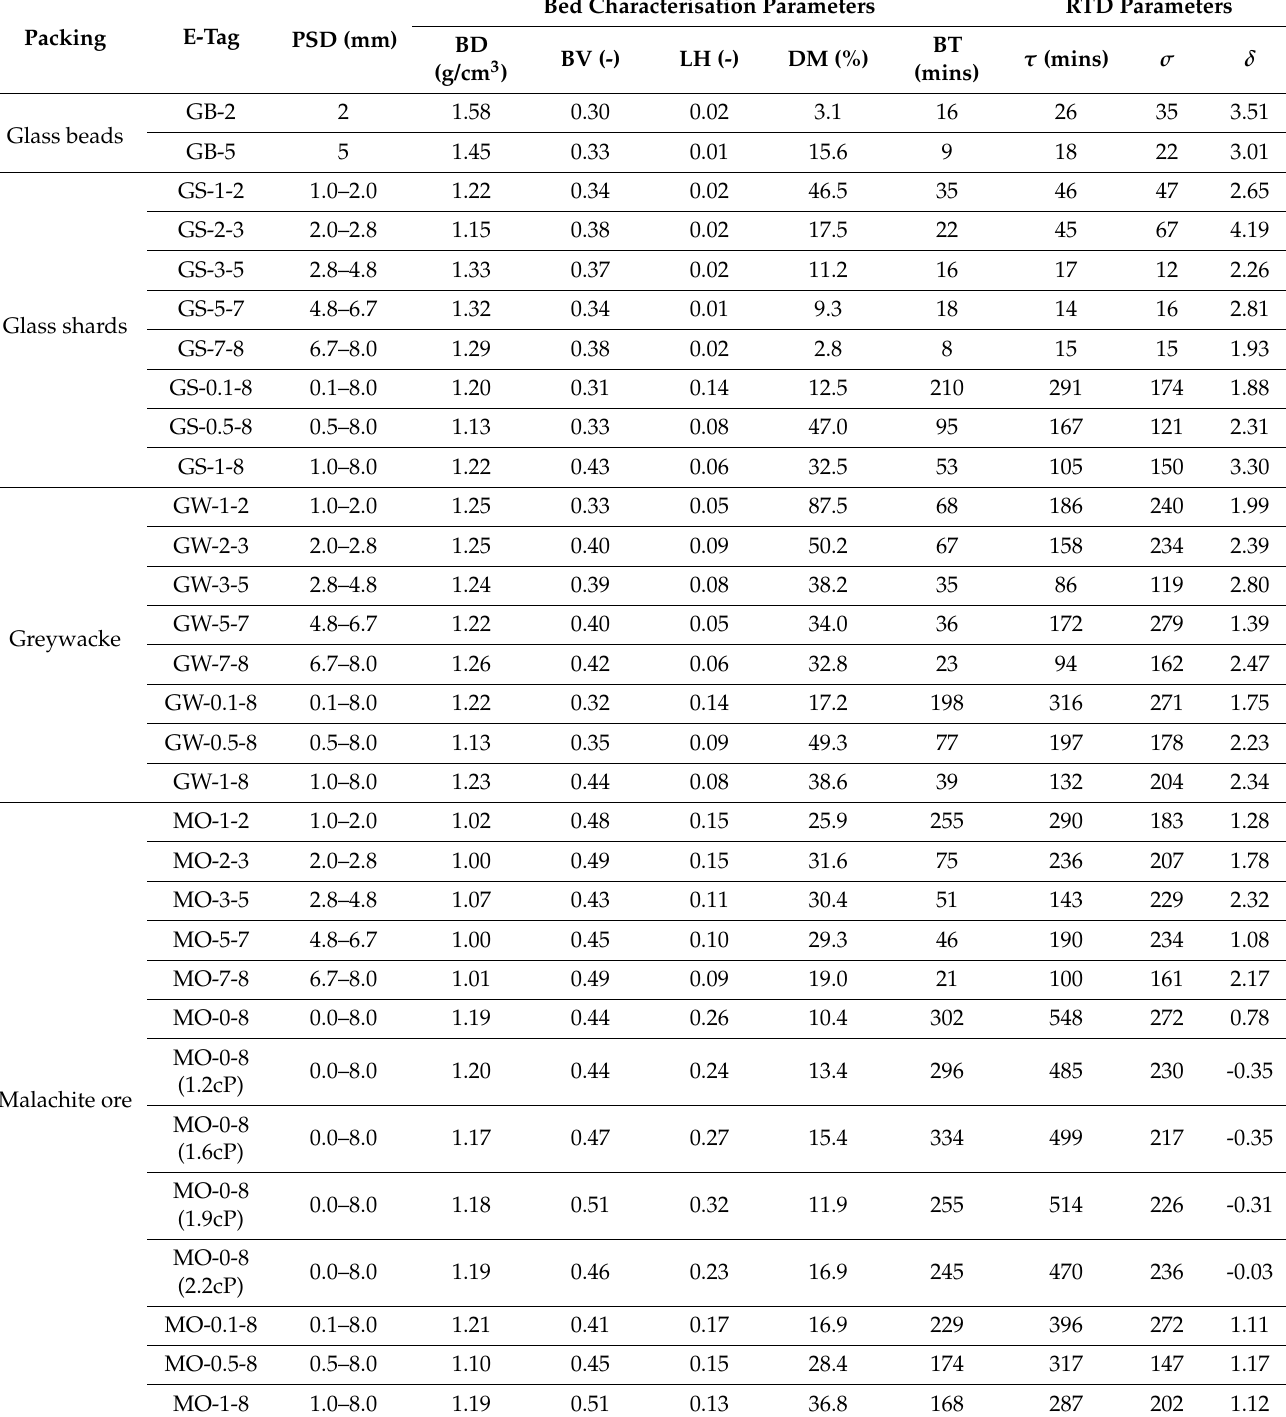
Table 7. Bed characterisation and quantified RTD parameters for packed beds composed of different size fractions of GSs, GW, and MO. Key: E-tag (experimental tag), PSD (particle size distribution), BD (bulk density), BV (bed voidage), LH (total liquid hold-up), DM (24-h drain-down moisture as a percentage of total liquid hold-up), and BT (solution breakthrough